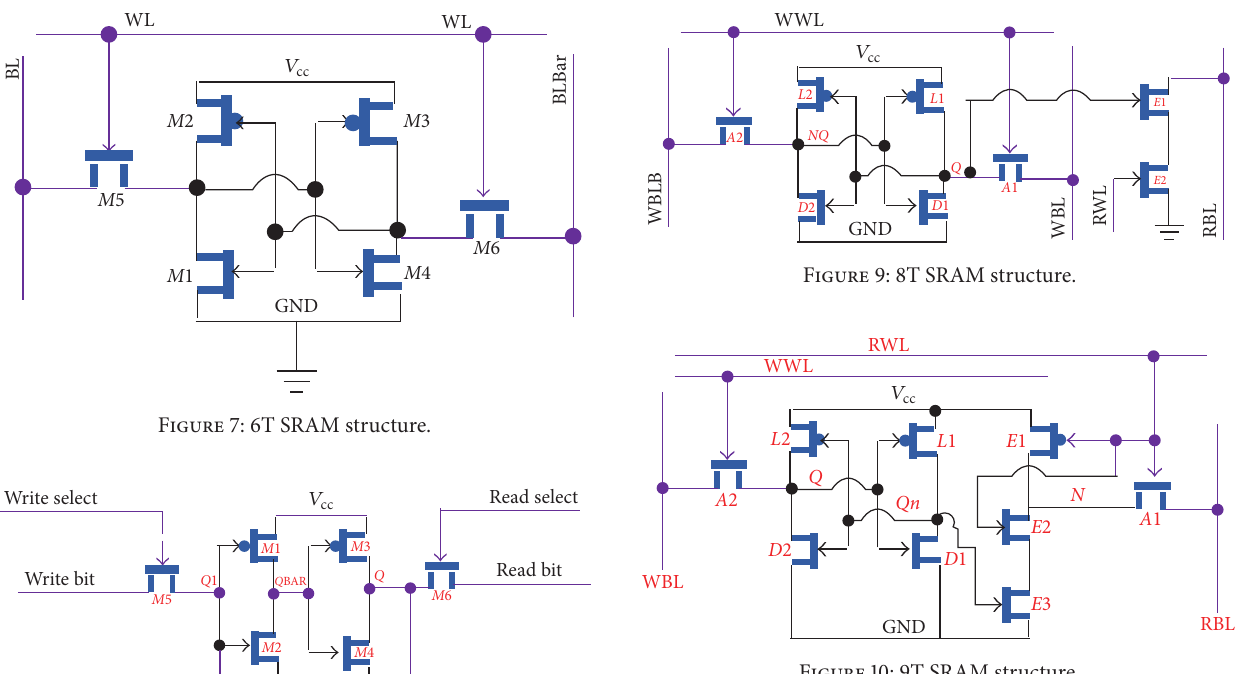
Figure 10: 9T SRAM